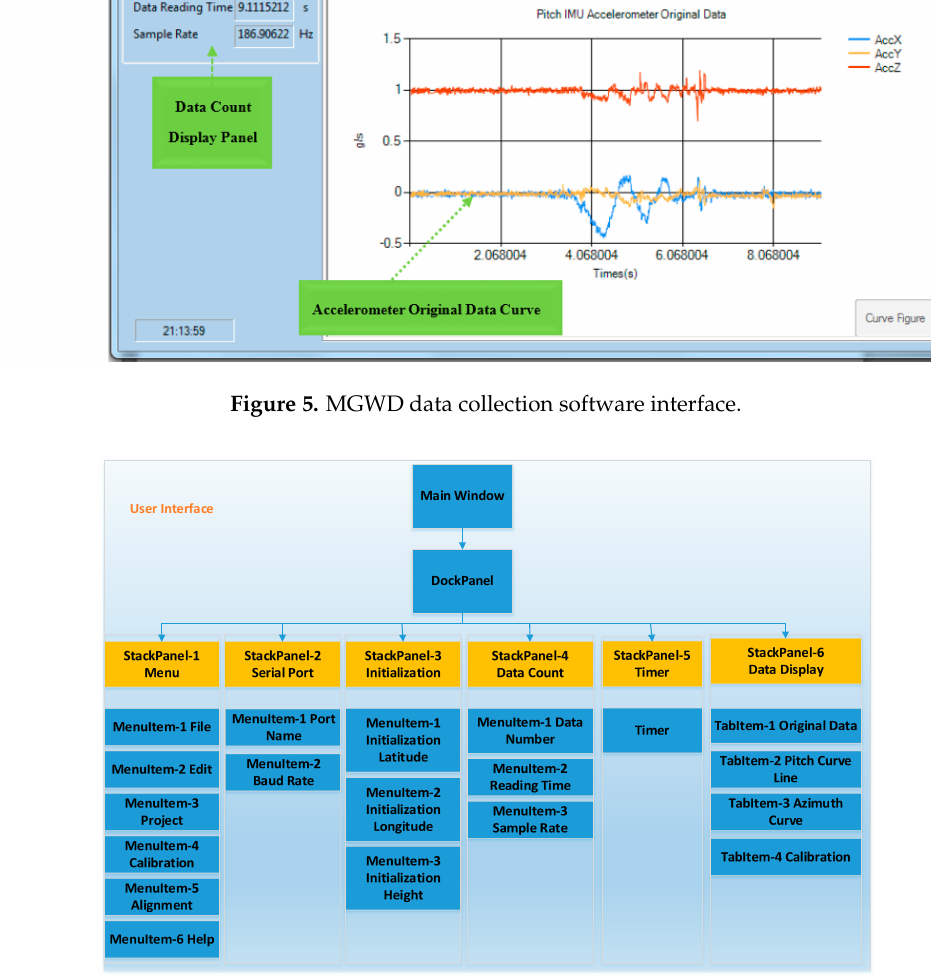
Figure 6. User interface design flow diagram.